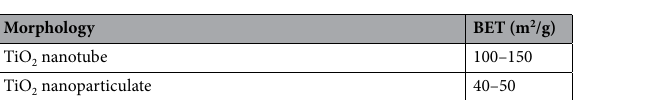
Figure 4. Normalized outputs. A comparison of ( a ) the measured normalized current and ( b ) measured normalized voltage of TENG under various RH between different morphologies of the triboelectric active layer.